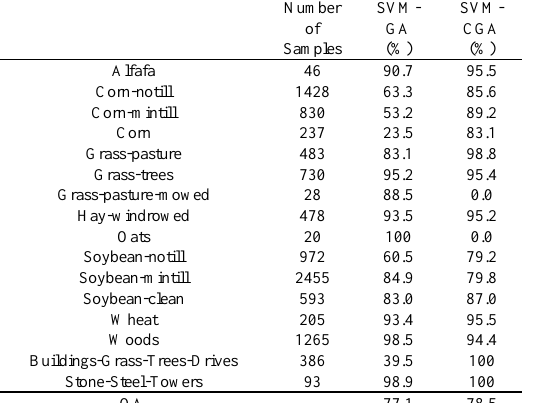
Table 2: Comparison of a classification performed using CGA and BGA (Santos et al.,